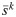
Solution landscape for all tested exponent vectors, showing the rank rk, predictive error ϵ, clustering strength s¯k and exponent values β1,…,6.